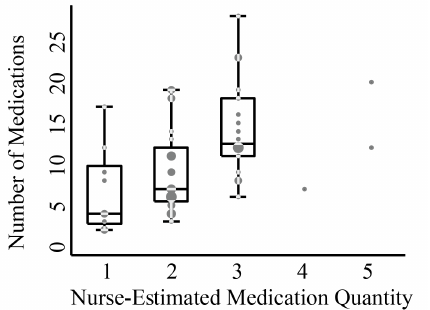
Figure 1. An ordered logistic regression indicated that nurse estimates of relative medication quantity predict actual number of medications. Larger dots indicate overlapping datapoints. We excluded categories 4 and 5 from the analysis due to data